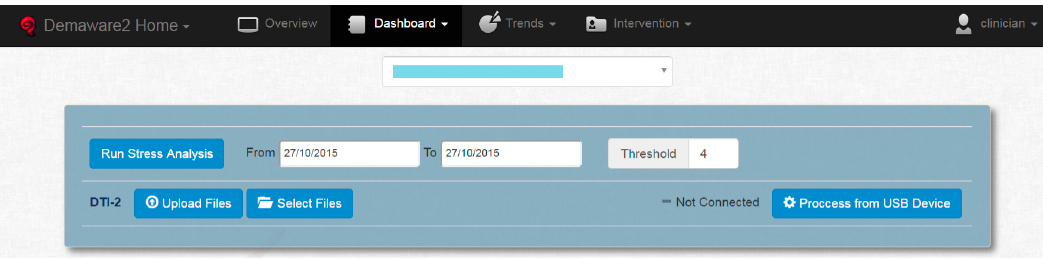
Figure 8. Dashboard for the clinicians to run analysis, setting a personalized stress level threshold